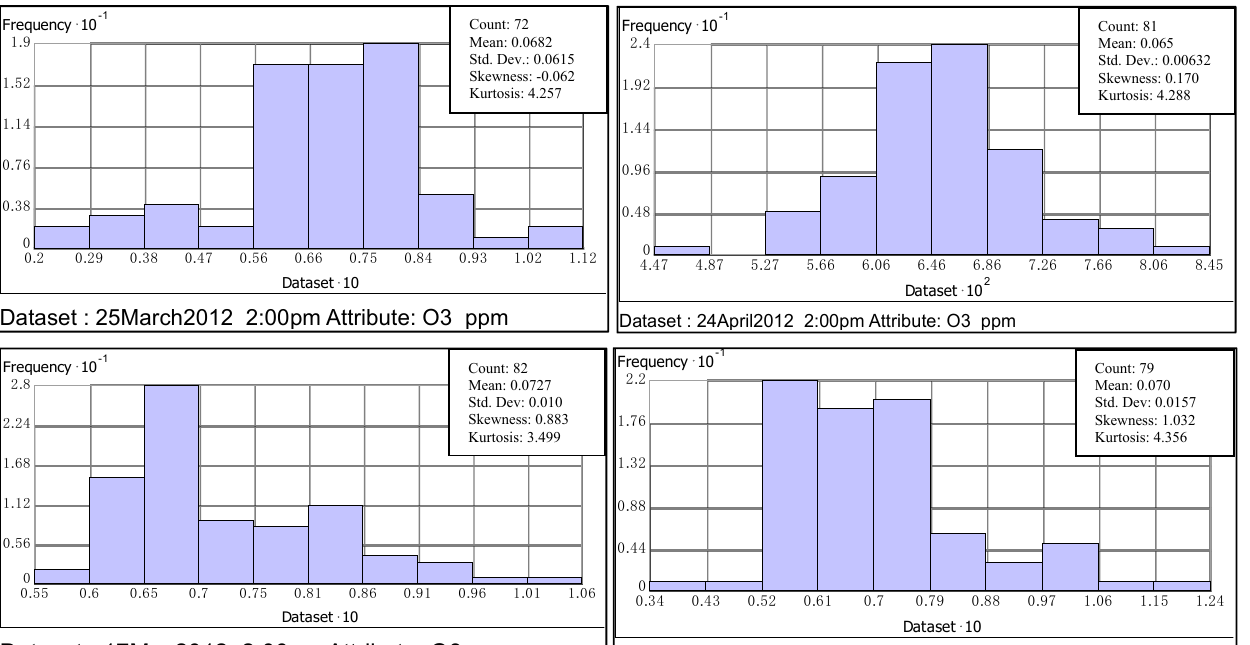
data for the studied 3